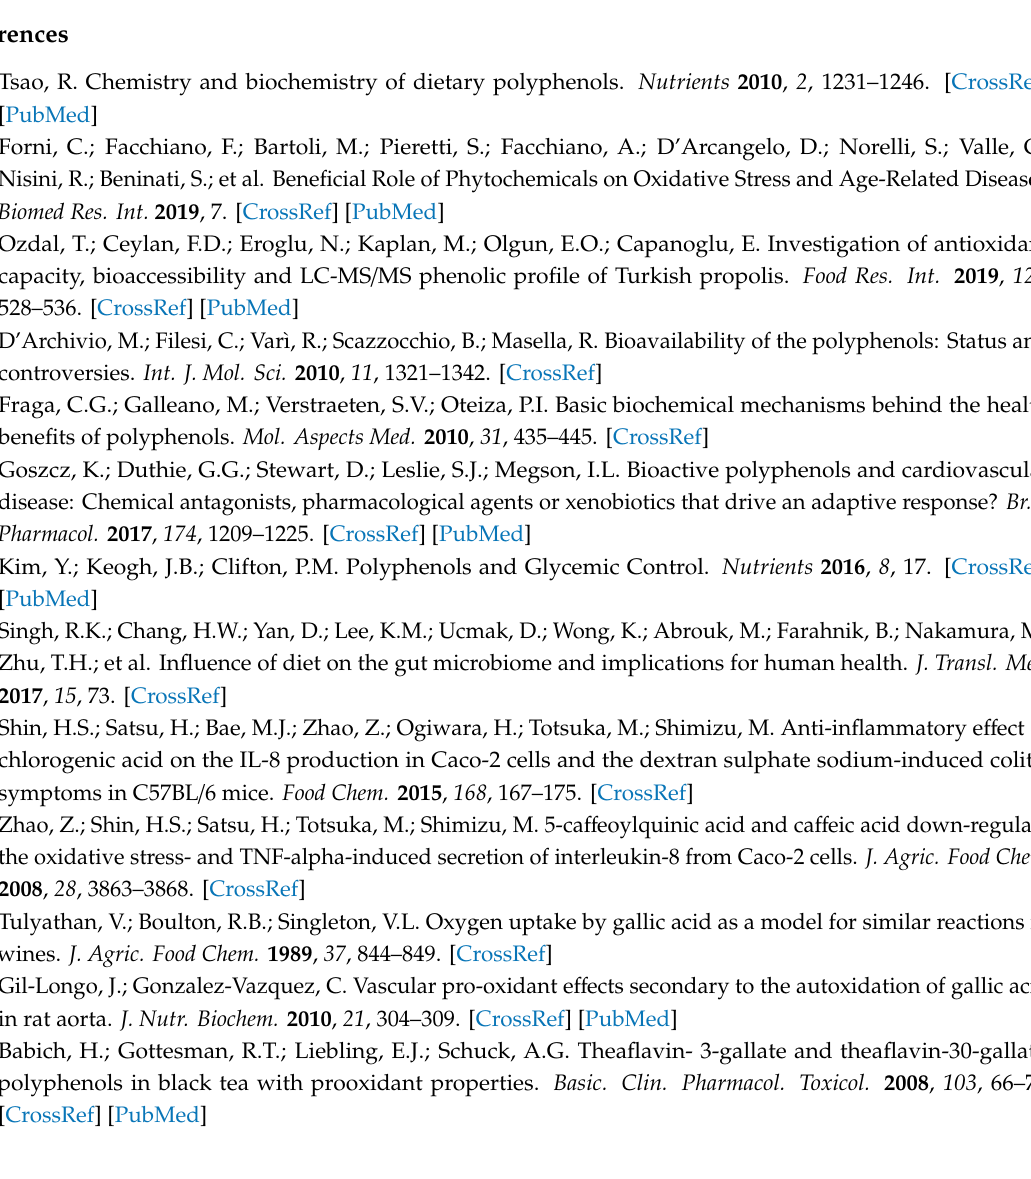
Figure S1: Chromatograms obtained with HPLC-MS / MS analysis of the gallic and ferulic acid contents in both Blueberry Supplement and Supplement A, Figure S2: Intestinal equivalents obtained by seeding NCM460 cells on dermal equivalents that were para ffi